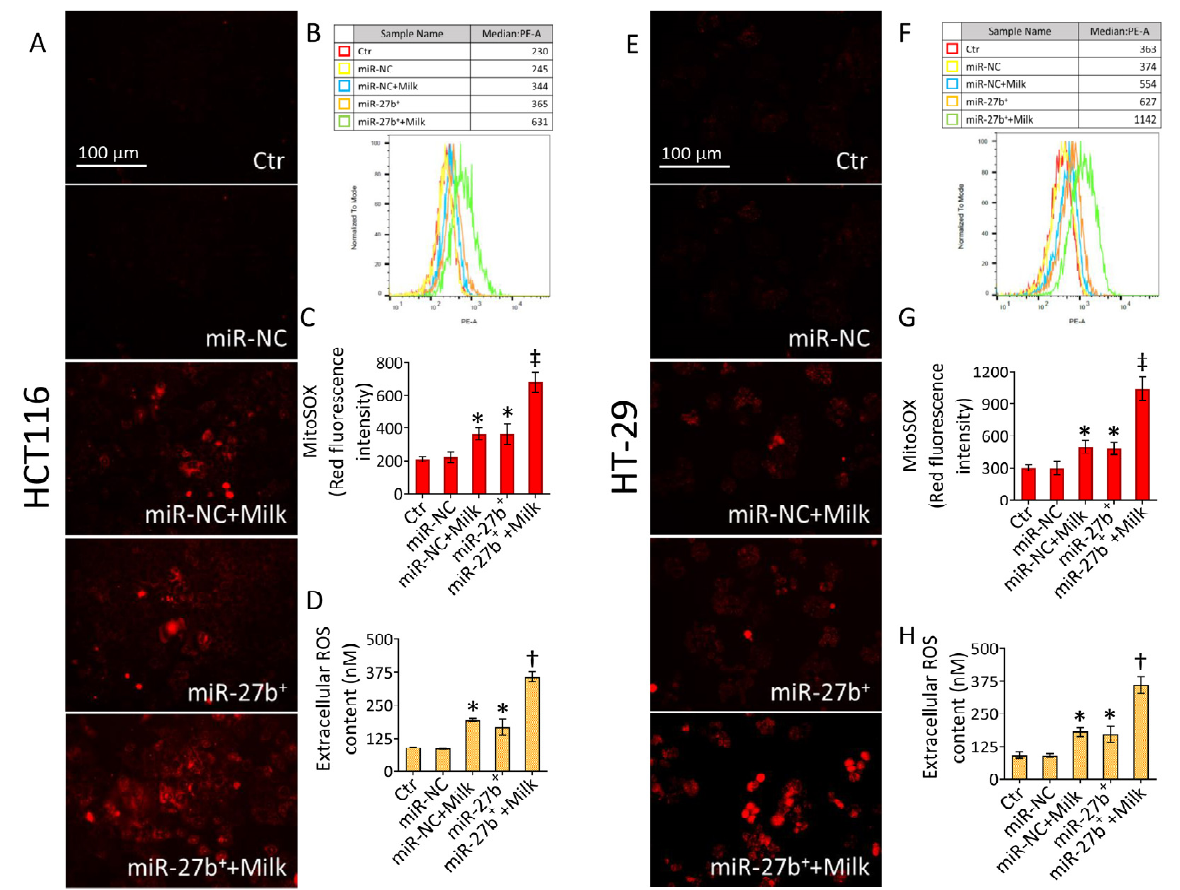
Figure 4. MiR-27b + + Milk provoked oxidative stress. Representative images by fluorescence microscopy and FACS analysis of mitochondrial ROS detection and extracellular ROS content in ( A – D ) HCT116 and ( E – H ) HT-29 cells transfected with 30 nM mimic Negative Control (miR-NC), miR-27b mimic (miR-27b + ), with miR-NC and miR-27b + before 72 h with 40% v / v milk treatment (miR-NC + Milk and miR-27b + + Milk). Control cells (Ctr) were treated with the upper volume of HBSS-10 mM Hepes. Scale bars = 100 µ m. * p < 0.05 vs. miR-NC; † p < 0.05 vs. miR-27b + ; ‡ p < 0.01 vs. miR-27b + .